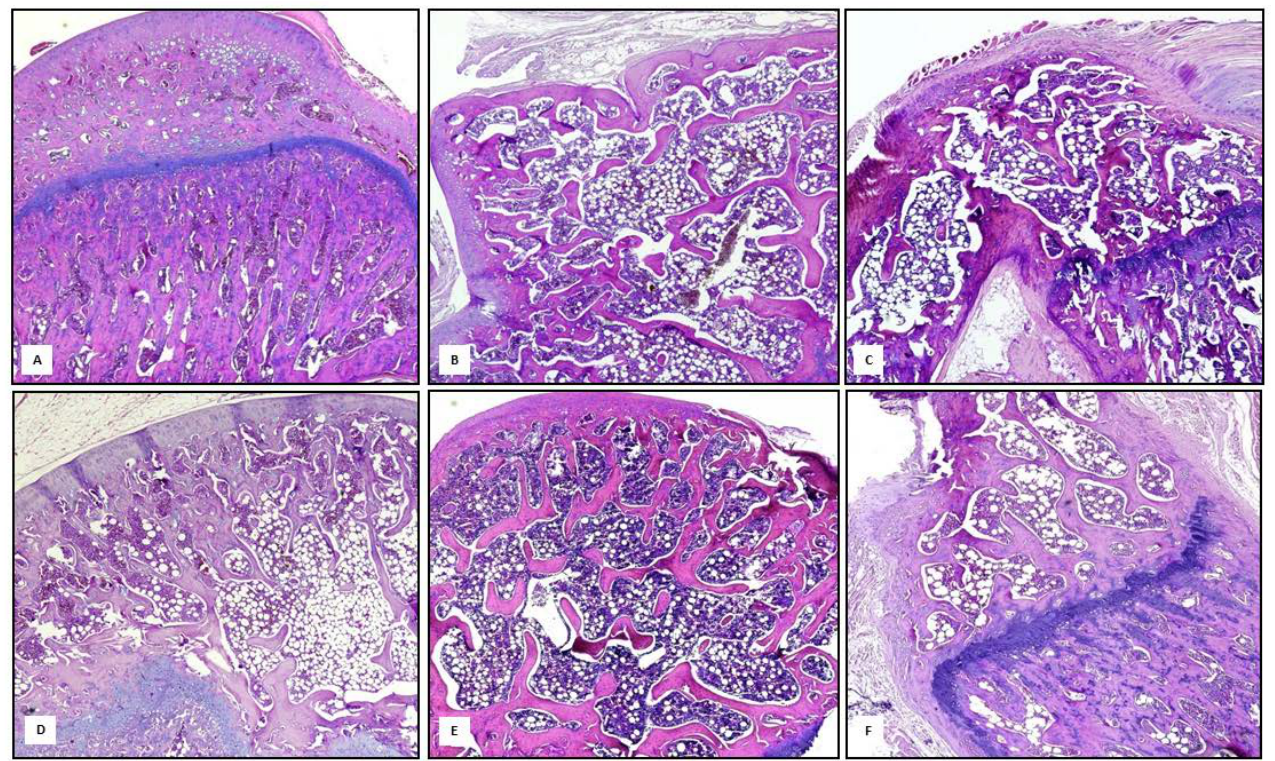
Figure 5. The images show Hematoxylin–eosin staining (original magnification 10 × ) performed on bone sections from Sham group ( A ), MP group ( B ), MP + Ale group ( C ), MP + GEN group ( D ), MP + LYCO group ( E ) and MP + GEN + LYCO group ( F